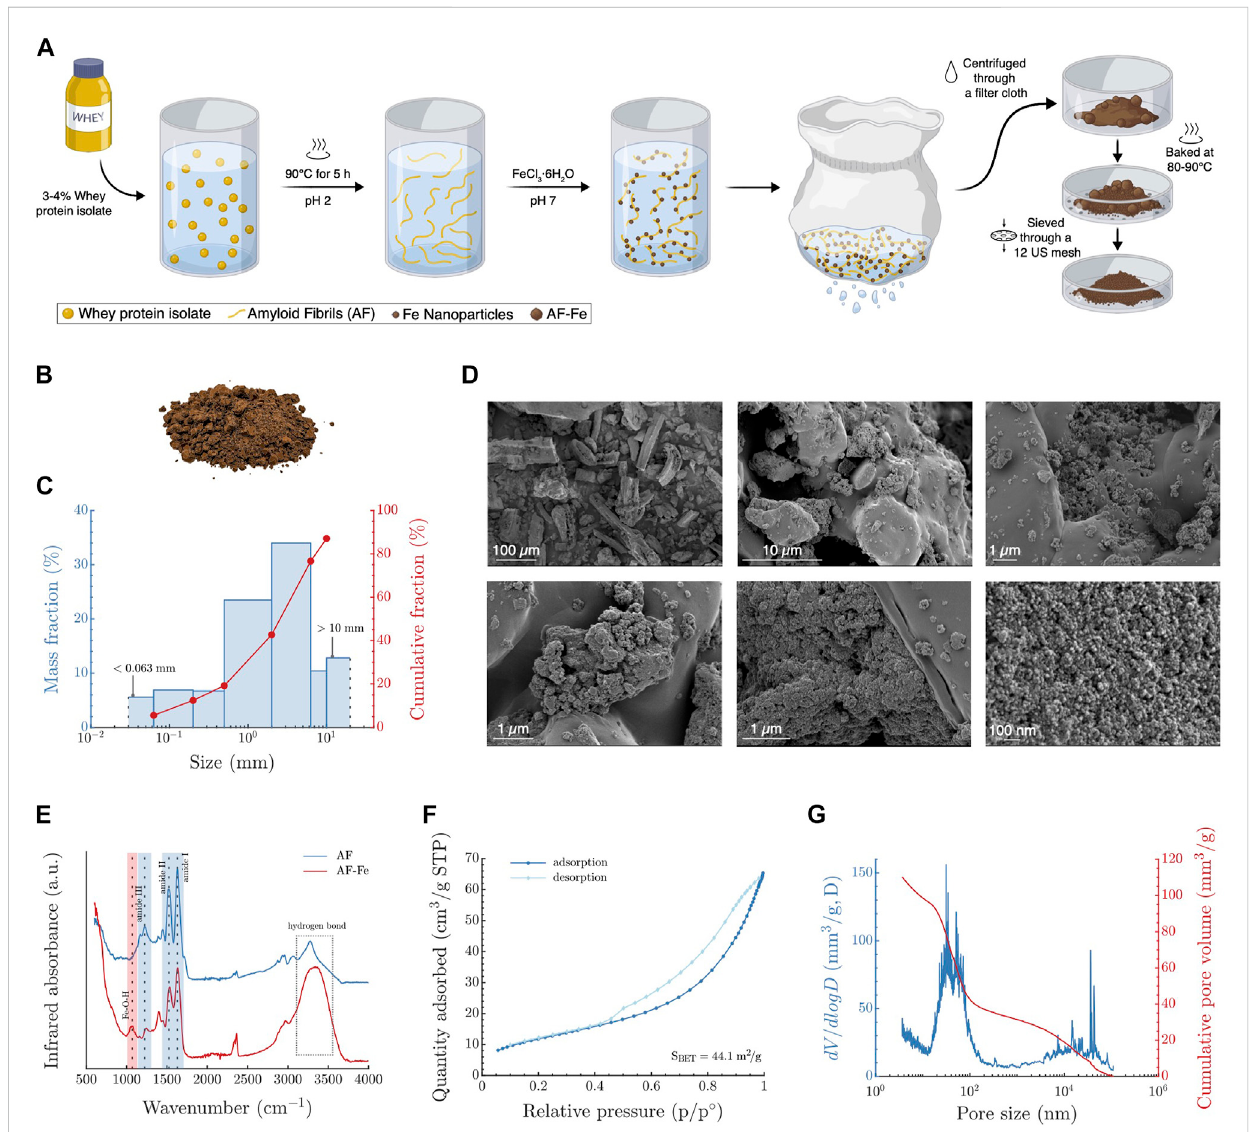
FIGURE 1 Fabrication and characterization of the granular AF-Fe. (A) A schematic showing the fabrication process of the AF-Fe. (B) A vectorized photo of the materialafter removingthebackground. (C) Sizedistribution oftheAF-Fe determinedusingsieveanalysis. (D) SEMmicrographsofthematerialatvarying magni fi cations. (E) FTIR analysis of both AF and AF-Fe. (F) N 2 adsorption analysis of the AF-Fe to determine its surface area. (G) Intra-particle pore size distribution of the AF-Fe determined using mercury intrusion